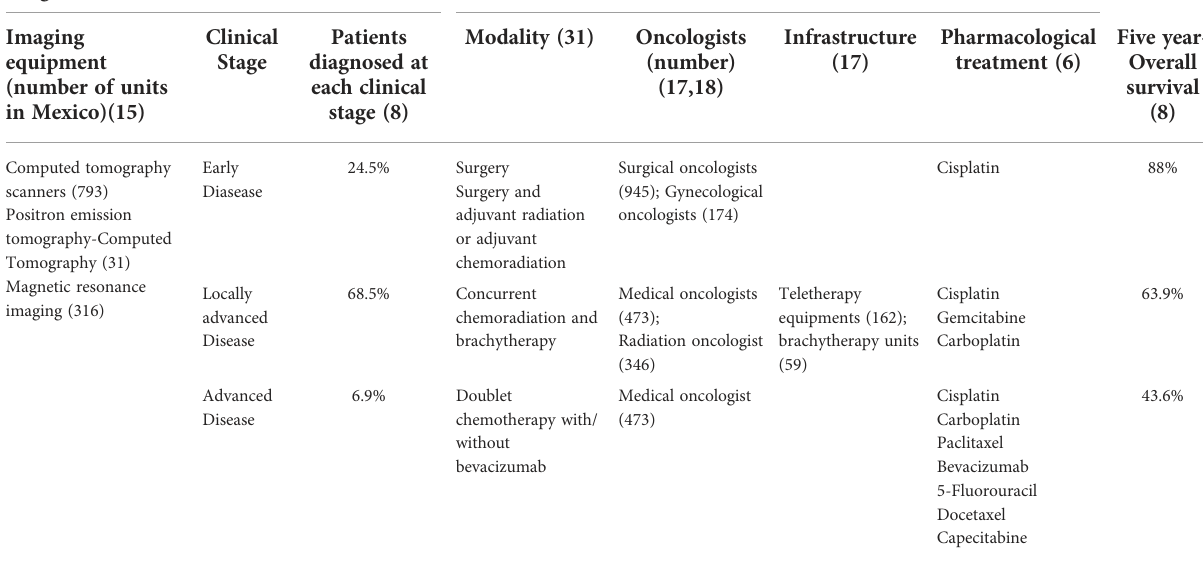
TABLE 1 Summary of resources for diagnosis and treatment of Cervical Cancer in